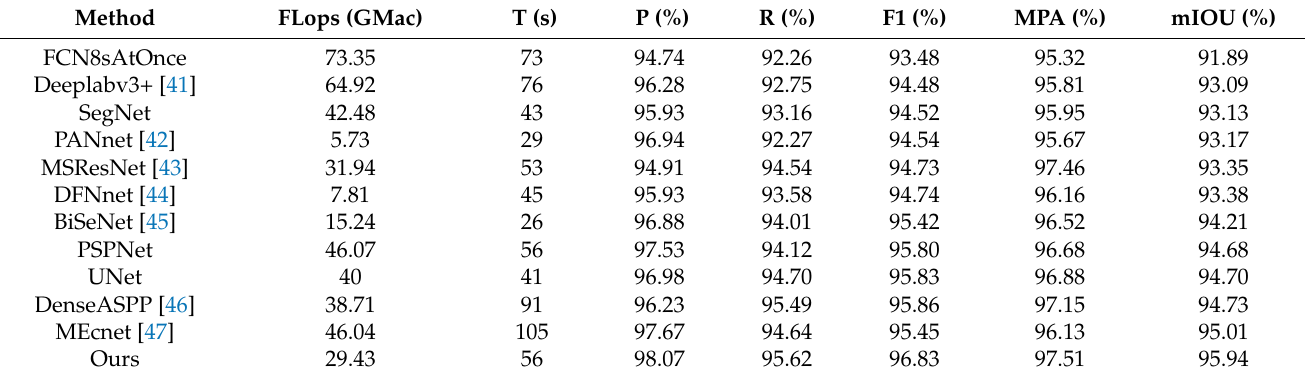
Table 3. Comparison results of different